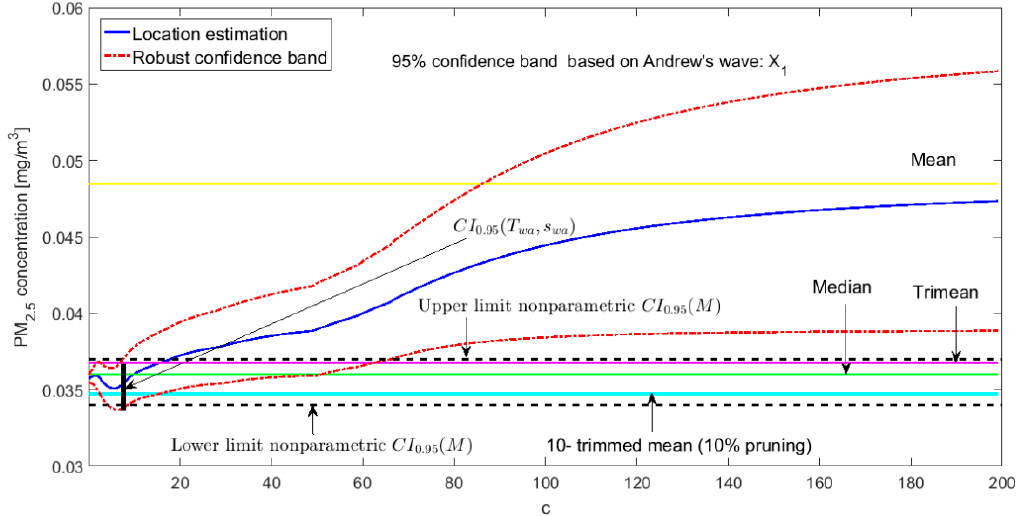
Figure 12. 95% robust confidence band based on the Andrew’s wave: X 1 .